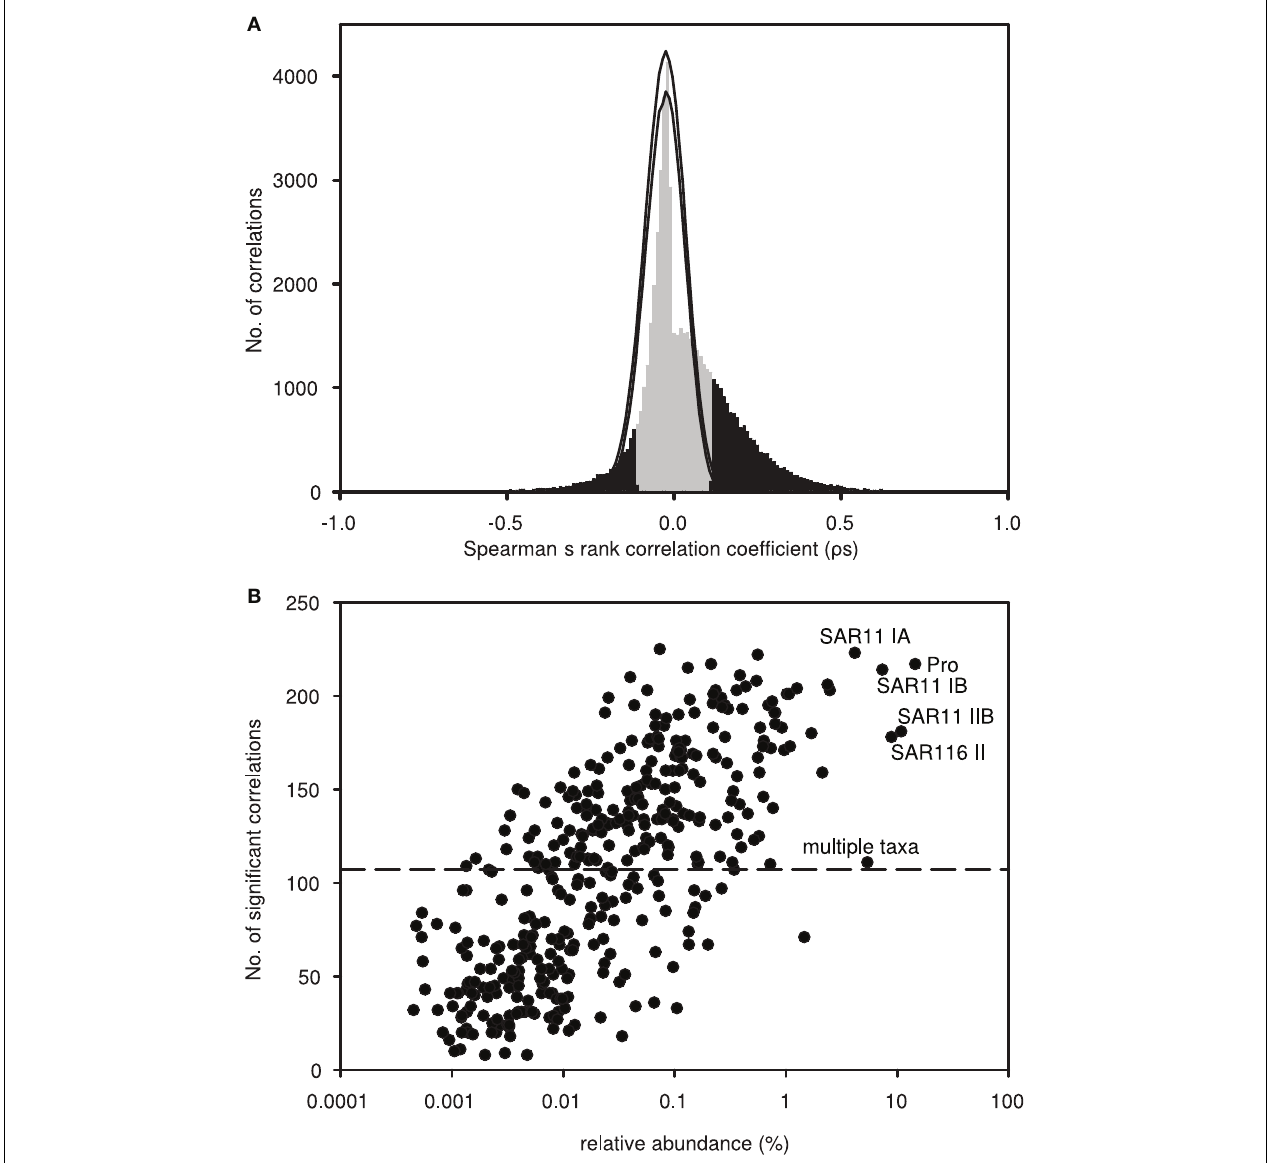
minimum numbers of correlations within each 0.01 interval (from 1 to − 1) were determined from all 1000 randomized matrices (hismax and hismin; black lines). (B) Plot of the average relative abundance of each OTU, determined viaT-RFLP, against the number of significant pair-wise correlations to other OTUs. Putative identities are indicated for the most abundant OTUs. The dashed line indicates the median number of significant pair-wise